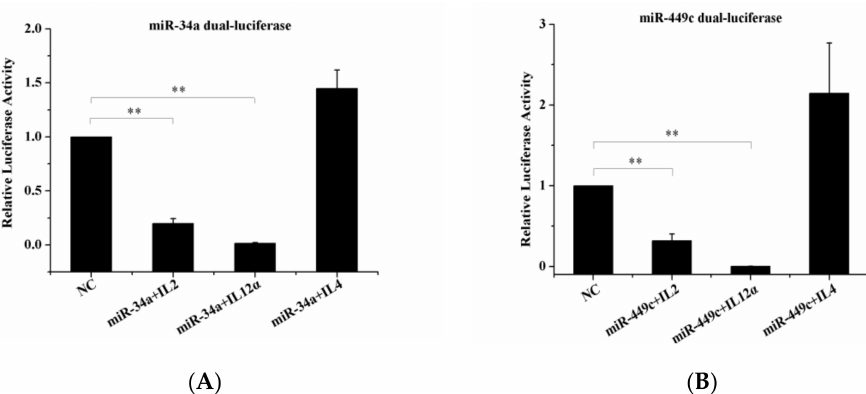
Figure 7. Dual-luciferase reporter gene assay confirmed targeted binding between IL-2, IL-12 α , and miR-34a, miR-449c. ( A ): 293-T cells were transfected with miR-449c mimic or an NC vector and then analyzed for miR-34a expression. ( B ): 293-T cells were transfected with miR-34c mimic or an NC vector and then analyzed for miR-449c expression. ** p < 0.05 compared with the NC group.